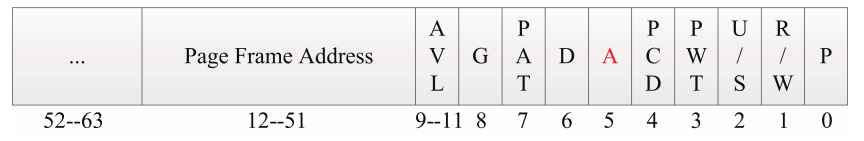
Figure 3. Data structure of modified page table